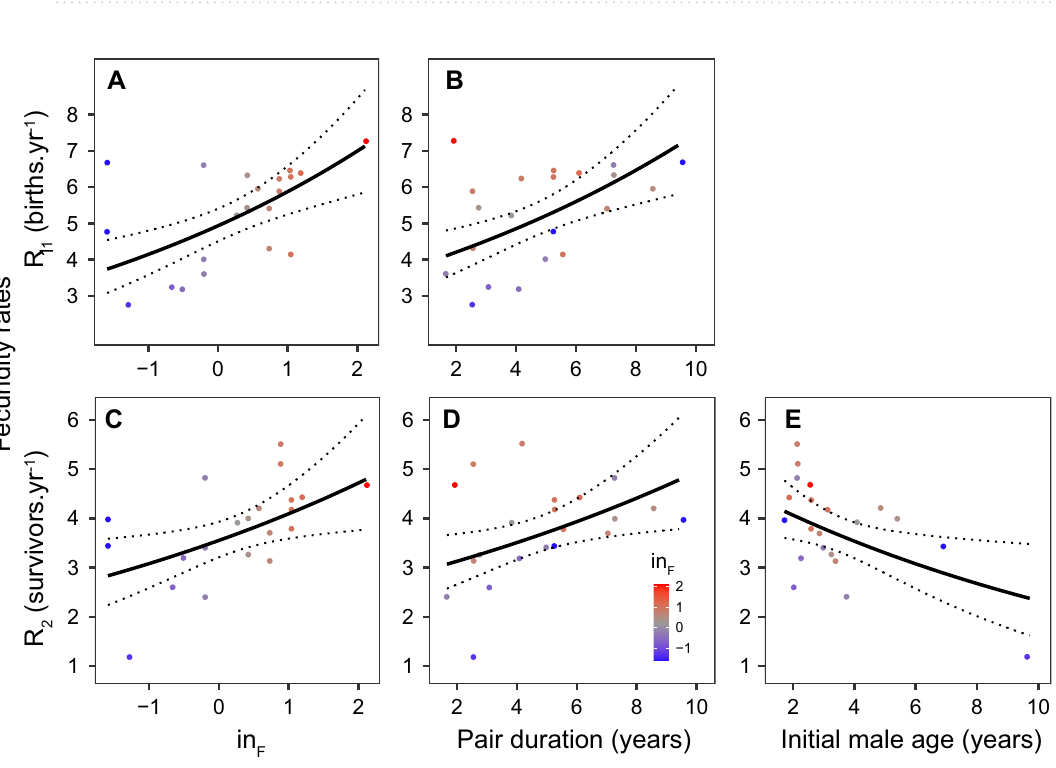
Figure 2. Effect plots for the most parsimonious model (lines: mean prediction ± 95% CI) linking the fecundity rates R 1 (number of all offspring born per year) ( A , B ) and R 2 (number of infants surviving until 3 months per year) ( C , D ) to female Inquisitiveness z -score in F ( A , C ), pair duration D ( B , D ) and male age at pair formation ( E ). Non-focal variable fixed at the mean pair duration ( A , C , E ), mean in F value ( B , D , E ) and mean male age at pair formation ( A – D ) in the dataset; points = individual observations coloured by in F